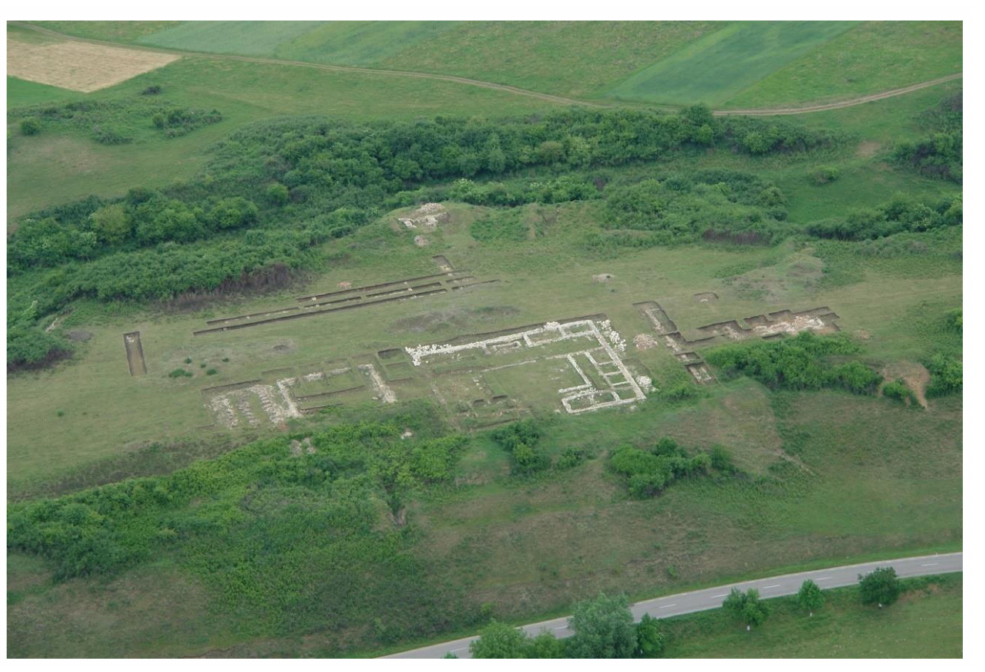
Figure 6. Aerial view of the Roman fort of Germisara ( © Museum of Dacian and Roman Civilisation,